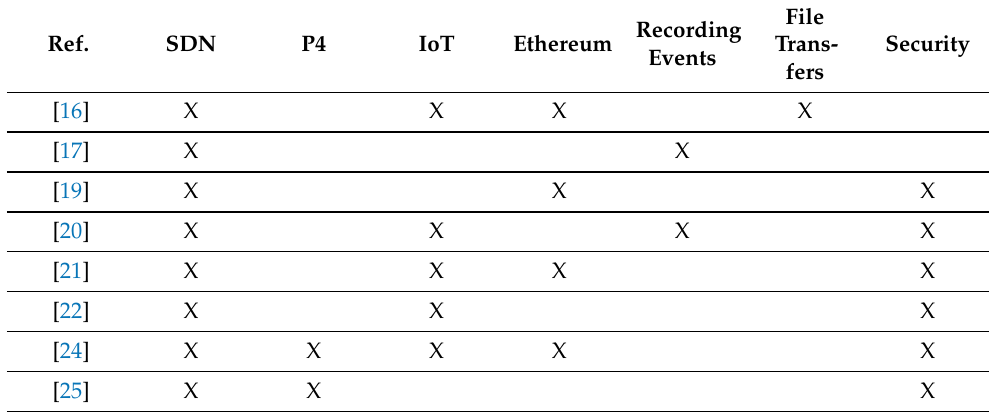
Table 1. Related works list of analyzed topics.